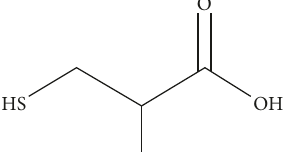
Figure 1: Cysteine